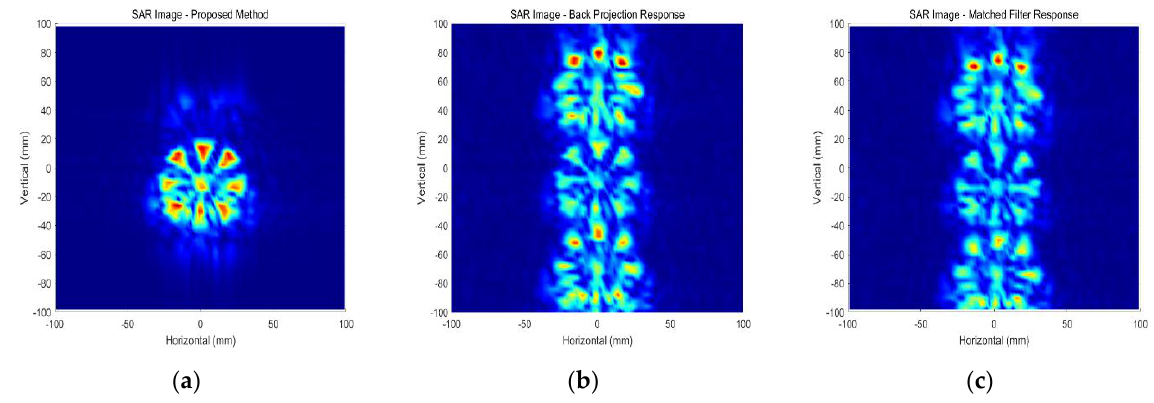
Figure 8. Vertical direction sparsely-sampled only: ( a ) mmSight; ( b ) Back Projection; ( c ) Matched Filter.